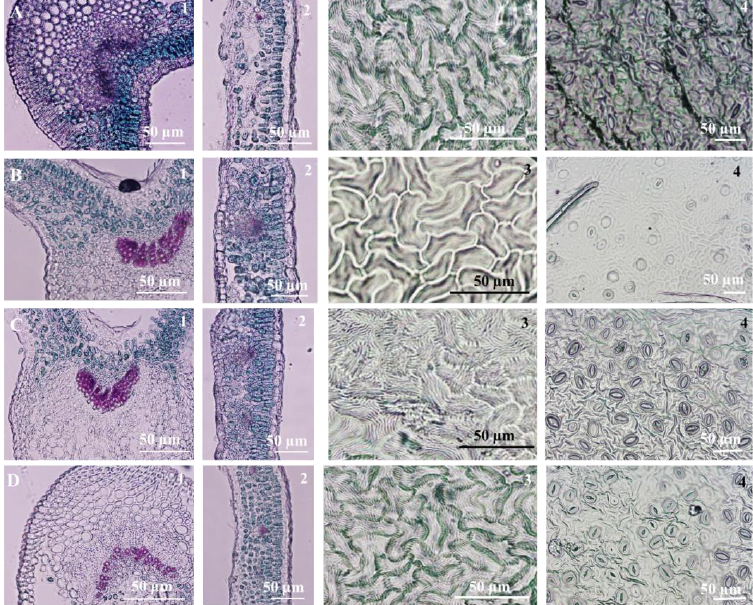
Figure 5. Cross sections of leaves in peach hybrids cultured in vitro: ( 1 ) central vein, ( 2 ) leaf, and casts of their integumentary tissues ( 3 ) adaxial epidermis, ( 4 ) abaxial epidermis. ( A ) ‘Clyde Wilson’ × ‘Nikitskiy Podarok’, ( B ) ‘Jerseyglo’ × ‘Nikitskiy Podarok’, ( C ) ‘Loadel’ × ‘Nikitskiy Podarok’, ( D ) ‘Summerglo’ × ‘Nikitskiy Podarok’. Bars = 50 μm.